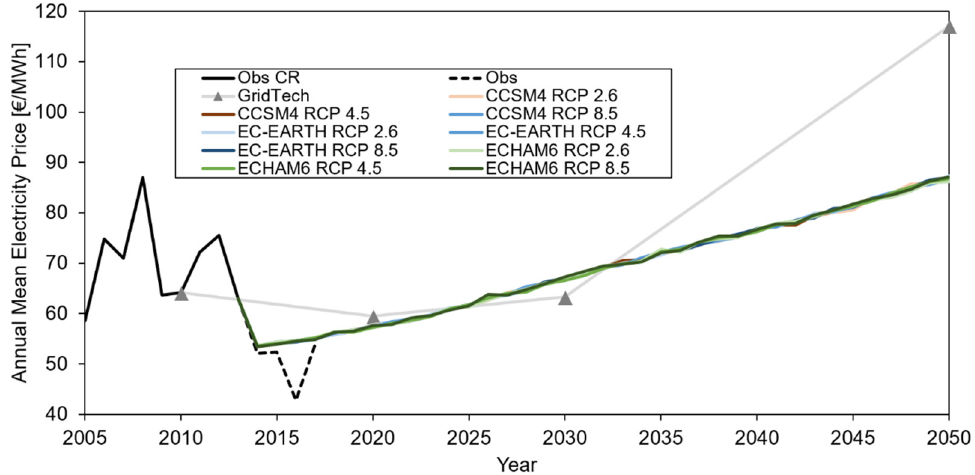
Figure 8. Electricity price. Observed and projected values to 2050 for benchmarking against the results from the GridTech project.